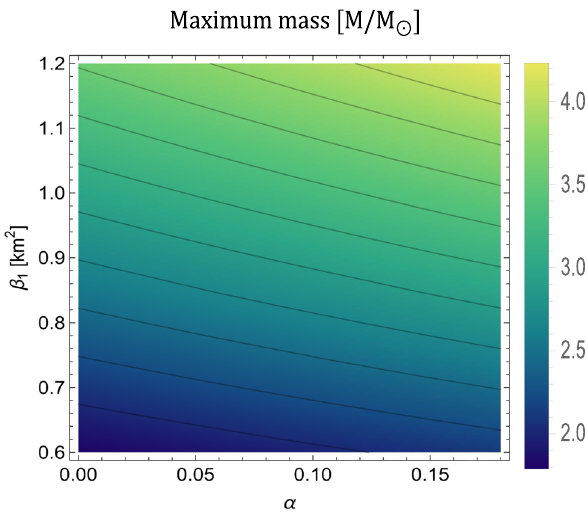
Fig. 8 The equi-mass diagram on α − β 1 plane with constant value C = 0 . 0043 km − 2 , and R = 13 .